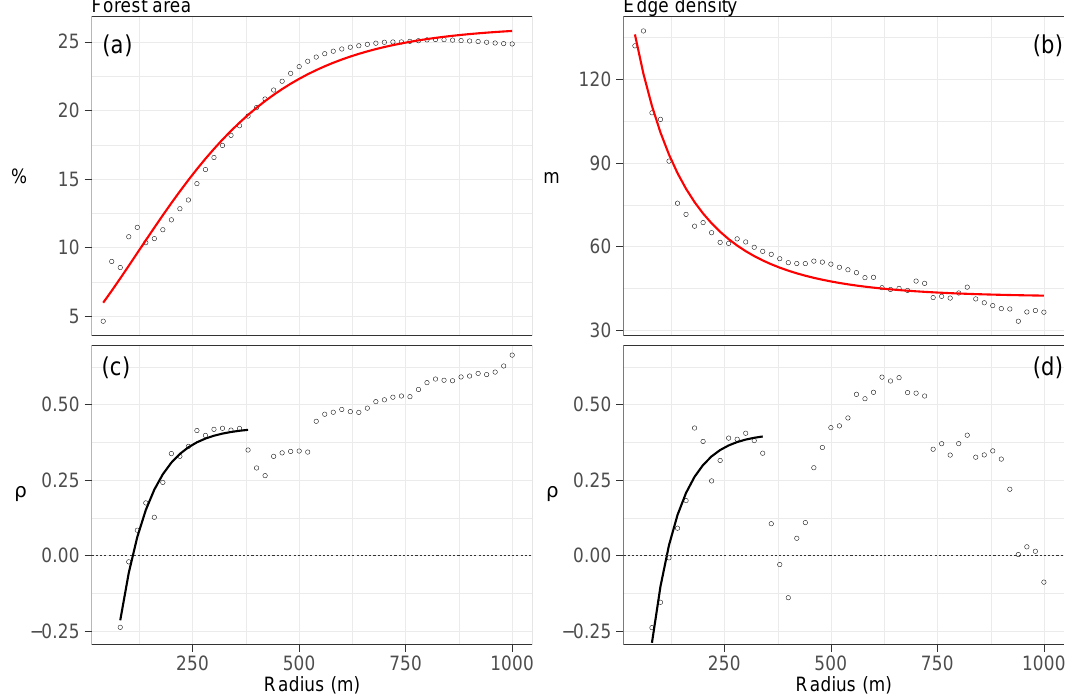
Figure 4. Forest area, edge density, and their Spearman correlation coefficients ( ρ ) with SWD at distances from 80–1000 m in 20 m intervals. Fitted red lines in ( a , b ) represent results from Gompertz functions (Equation (2)). The black lines in ( c , d ) are results from limited growth models (Equation